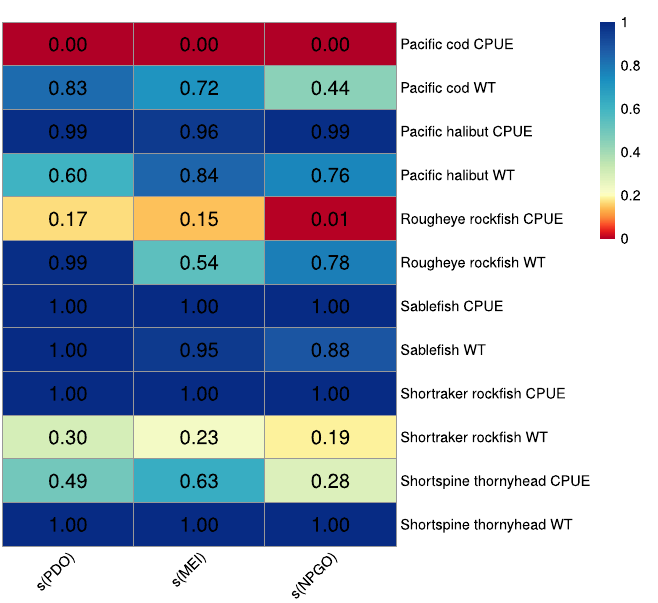
Figure 9. Heatmap of P -values for nonlinear relationship between groundfish CPUEs or WTs each year and lagged yearly seasonal amplitudes of climate indices PDO, MEI, and NPGO fitted using generalized additive models (GAMs). Colors and abbr. are as described in Fig.